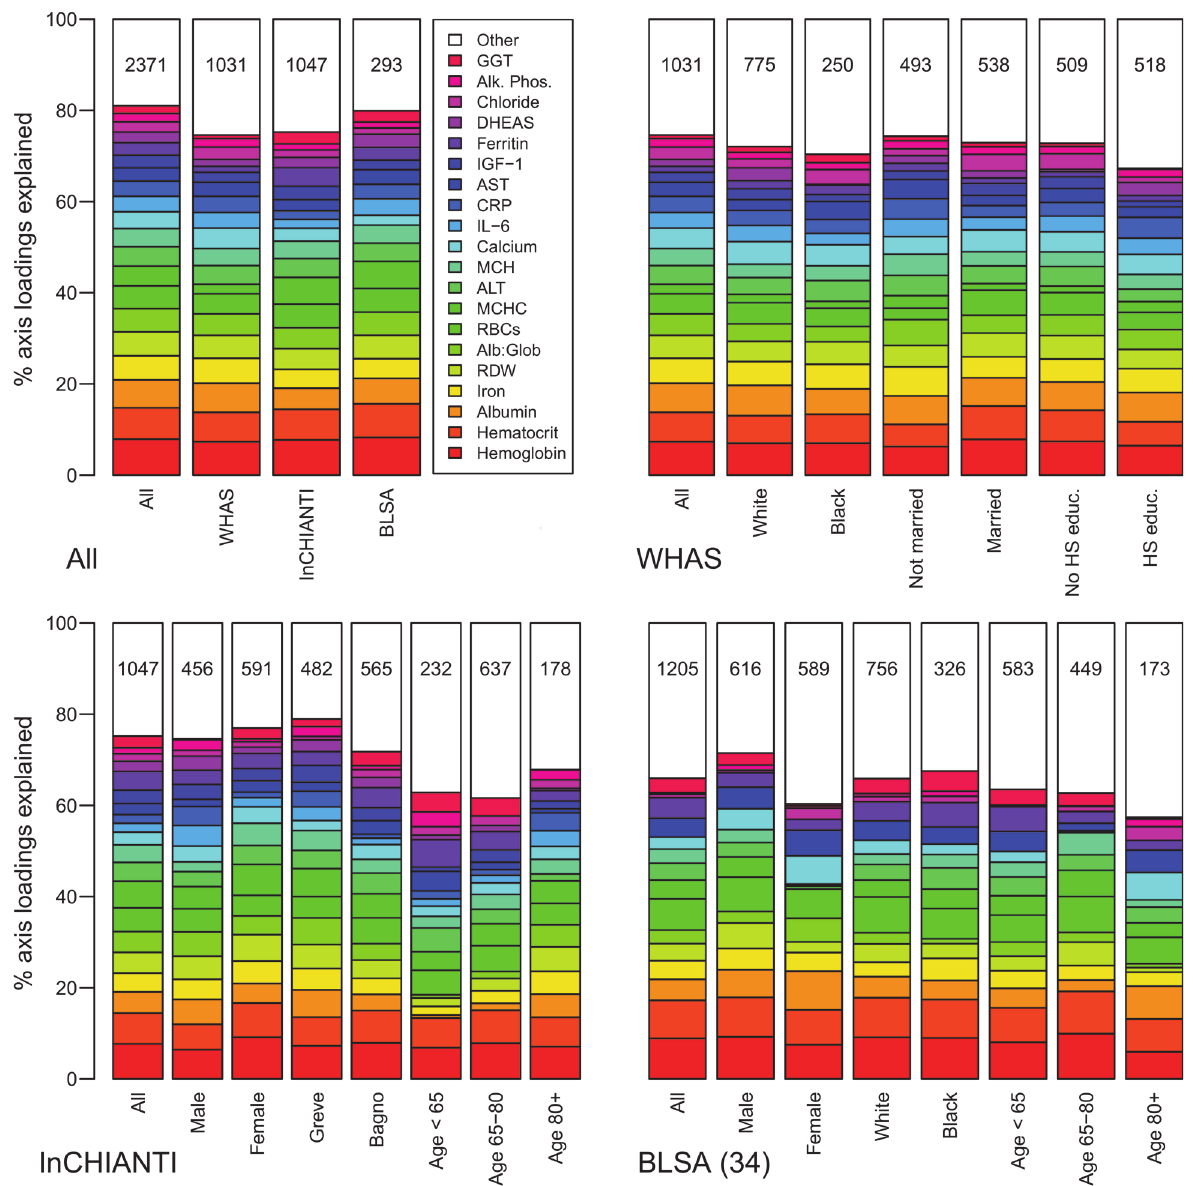
Fig 1. Biomarker loading order and stability for PCA1 across datasets and subsets. Loading importance is calculated as the loading divided by the sum of the absolute values of all loadings. These values are ordered from high (red, on bottom) to low (magenta, on top) for the first 20 loadings; remaining loadings are grouped together as “ Other ” in white. Accordingly, hemoglobin has the strongest loading, then hematocrit, then albumin, etc. The order and colors are derived from the full analysis combining the first visits of individuals in all three datasets (top-left panel, left column, “ All ” ) and applied to all other columns in the figure. Stability of loadings is indicated by conservation of loading heights across bars. (For an example of unstable loadings, see Fig. 5.) For each panel, the loadings for the full dataset are at left. Numbers indicate subset sample sizes. For all panels except BLSA, the 43-variable set is used; for BLSA there was insufficient sample size to perform PCA on subsets with 43 variables, so the 34-variable analysis is